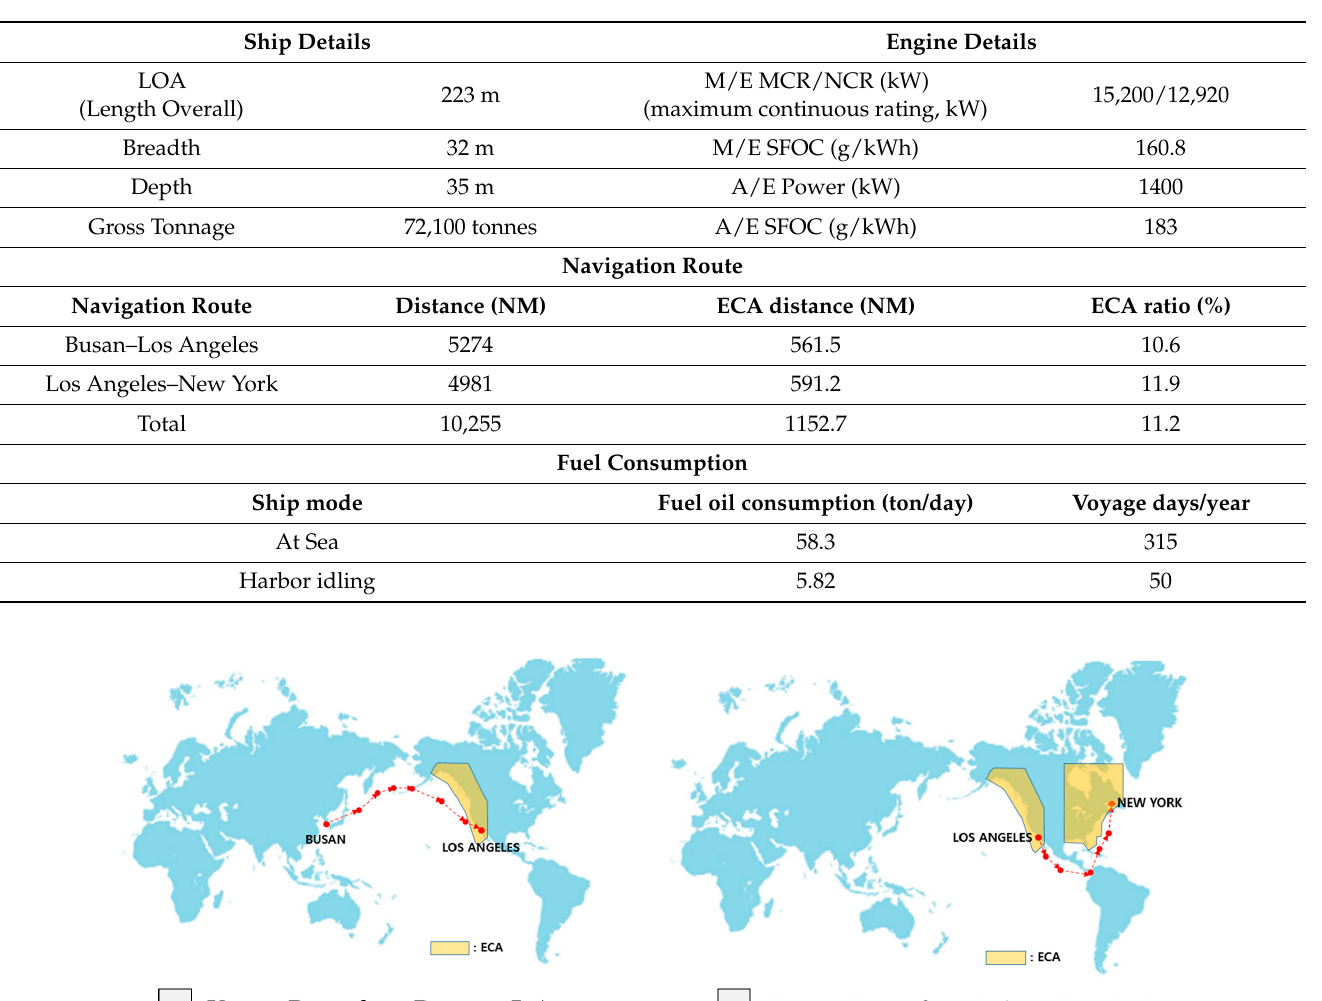
Table 1. Case ship Specifications.